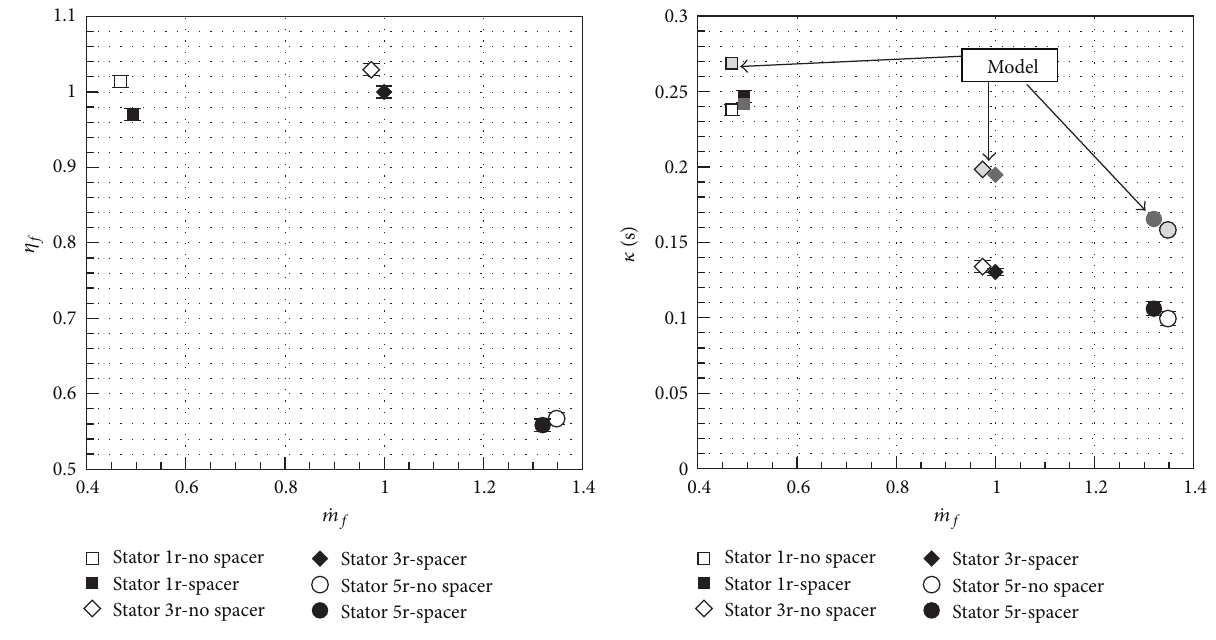
Figure 5: Final operating point and reactivity of the stage for three opening configurations of the stator.